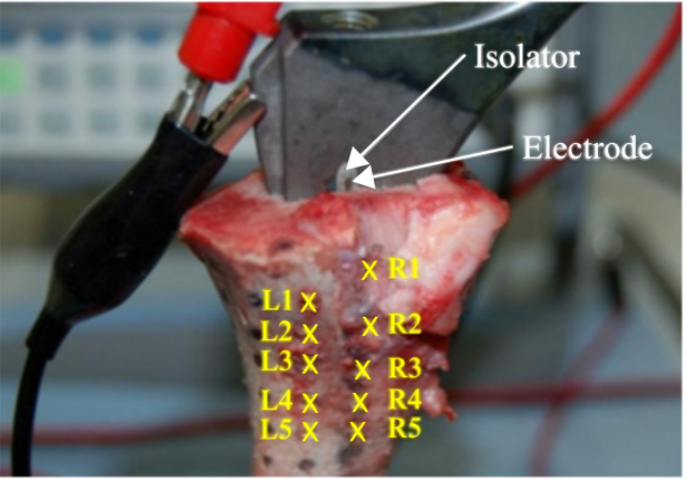
Figure 2. Experimental setup with the connected hip stem. A raster of 10 different readout locations at the surface of the porcine femur was